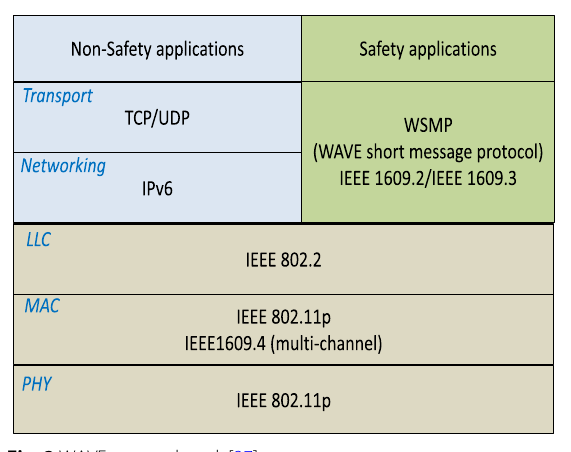
Fig. 2 WAVE protocol stack [27]